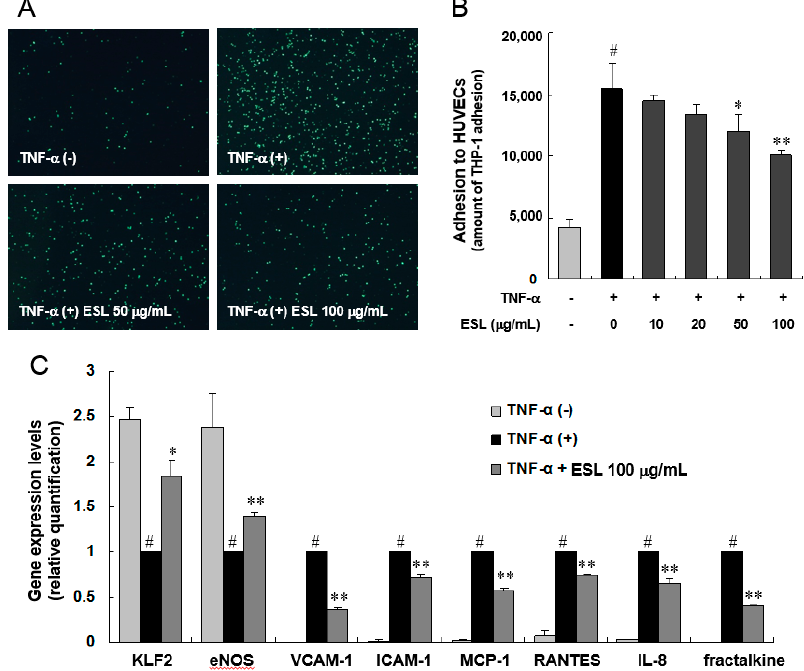
Figure 1. Effects of extract of soy leaf (ESL) on THP-1 monocyte adhesion and expression of atherogenic genes in TNF- α -stimulated human umbilical vein endothelial cells (HUVECs). ( A ) HUVECs were pretreated with or without ESL at the indicated concentrations for 2 h, and then stimulated with 10 ng/mL TNF- α for 8 h. Calcein AM-labeled THP-1 monocytes were added to each well for 1 h, the non-adherent cells were removed by rinsing, and adherent cells were visualized using fluorescence microscopy with a fluorescein blue filter (magnification, 40 × ); ( B ) The bar graph represents the amount of THP-1 adhesion to HUVECs; ( C ) TNF- α -induced expression of adhesion molecules and chemokines was quantified by real-time qRT-PCR as described in the Experimental Section. # p < 0.01 vs. the untreated group. * p < 0.05 and ** p < 0.01 vs. the TNF- α -treated group.